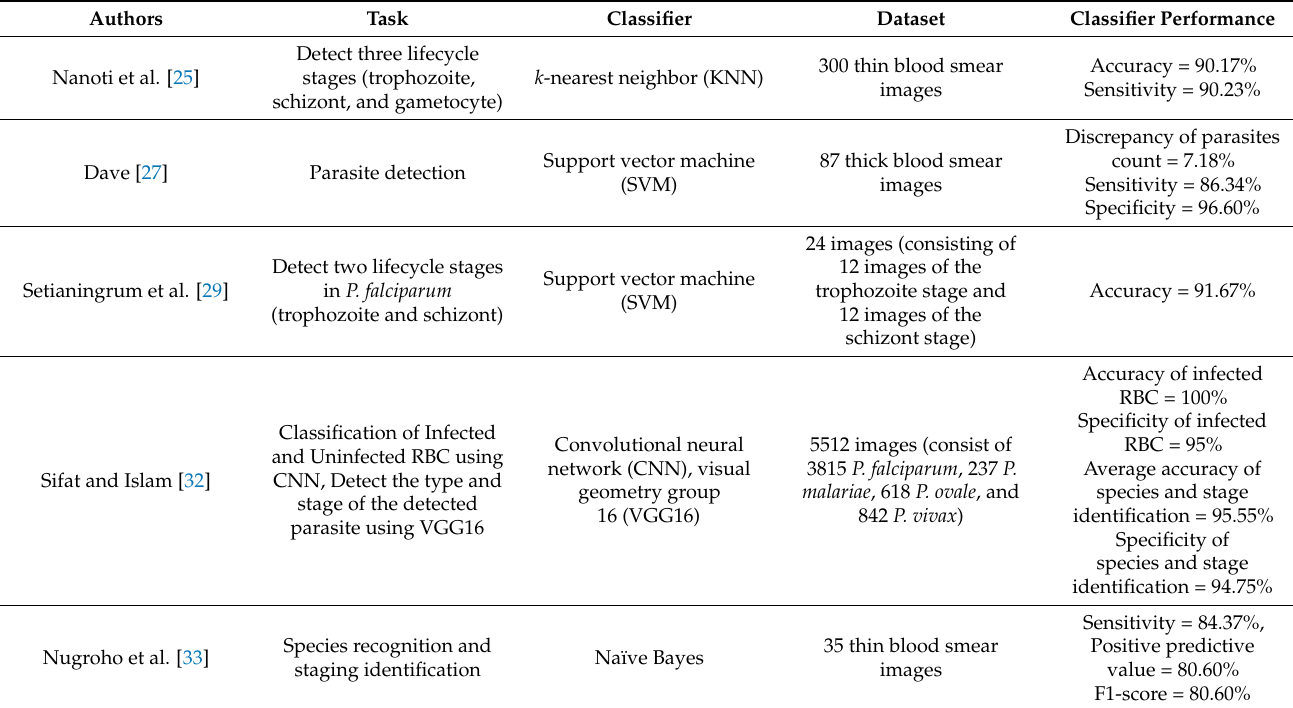
Table 9. Comparison of our proposed classifier performance with the current relevant